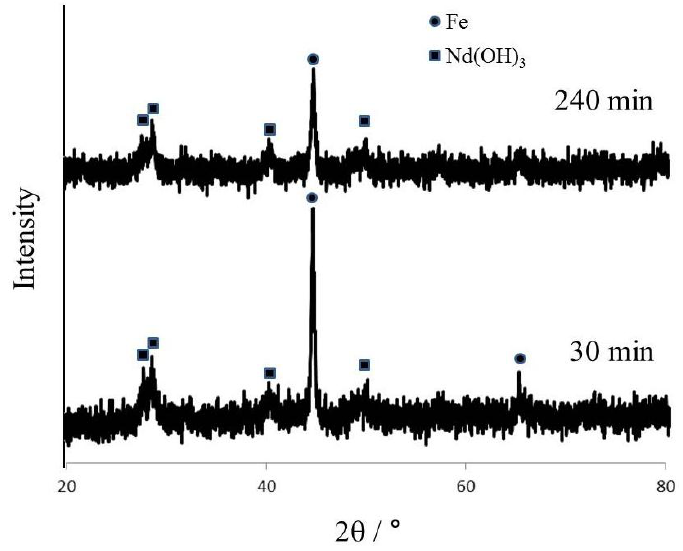
Figure 2. XRD patterns of ground products with grinding time (Grinding